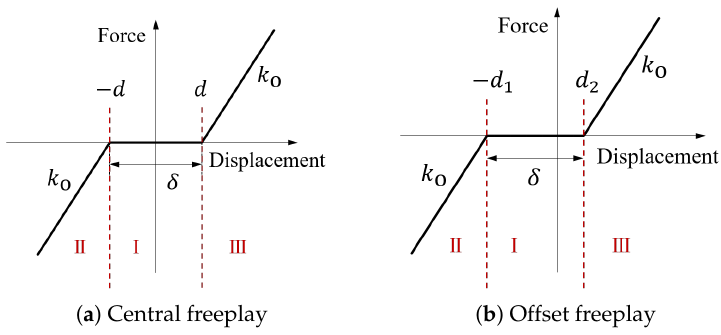
Figure 2. The restoring force of